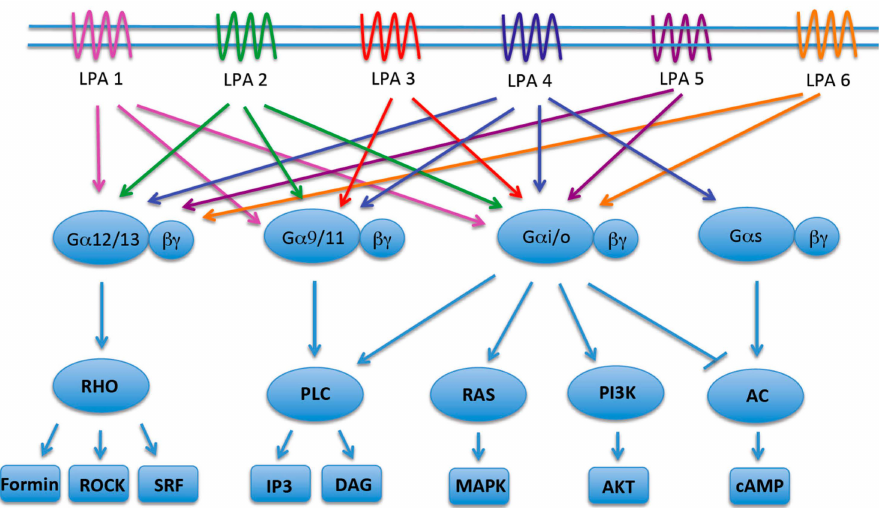
Figure 2. Cell surface LPA receptors and their downstream signaling pathways: LPA signaling is mediated by six known 7-TM receptors that are coupled to members from at least two of four trimeric G-protein families. LPA signaling regulates critical cellular responses such as cytoskeletal changes, cell motility, proliferation, and resistance to